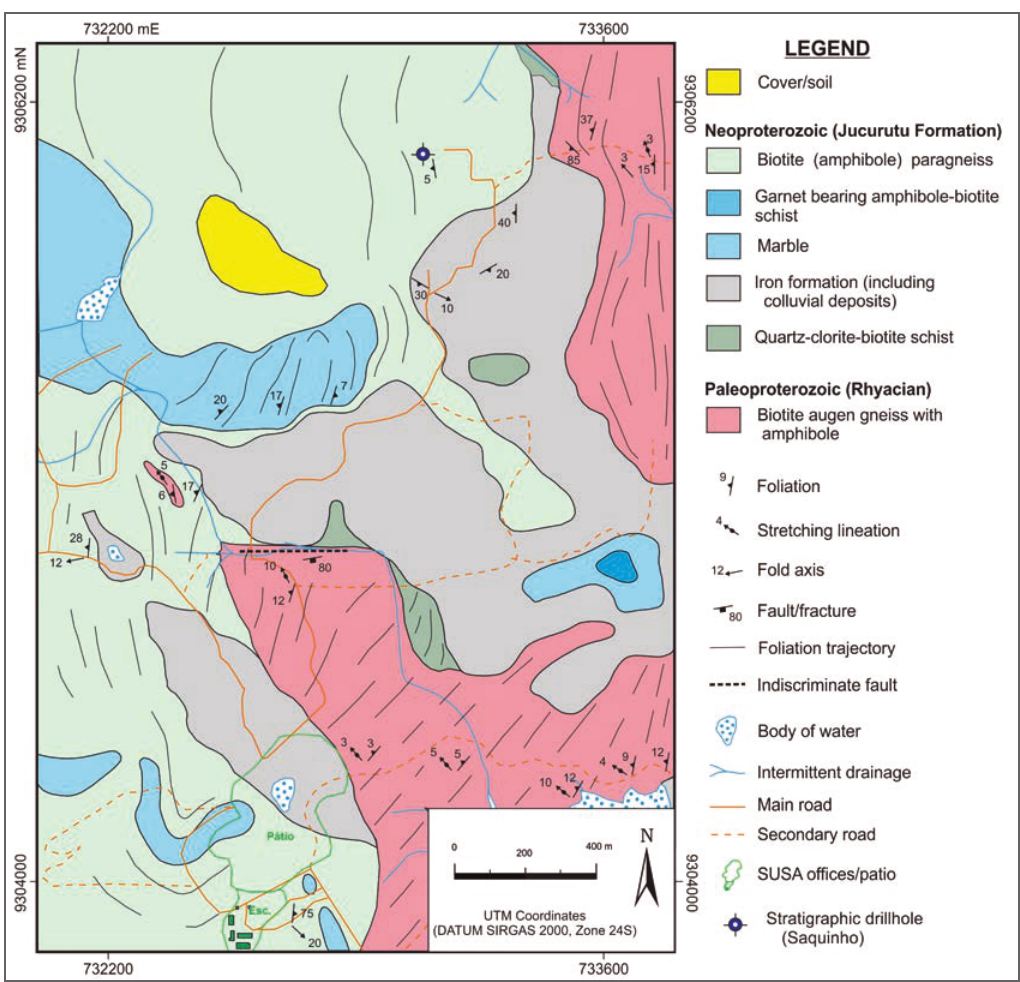
Figure 3 - Geological map of the northern portion of the Saquinho iron mine, adapted from the data provided by Susa Indústria e Comércio de Produtos Minerários Ltd.